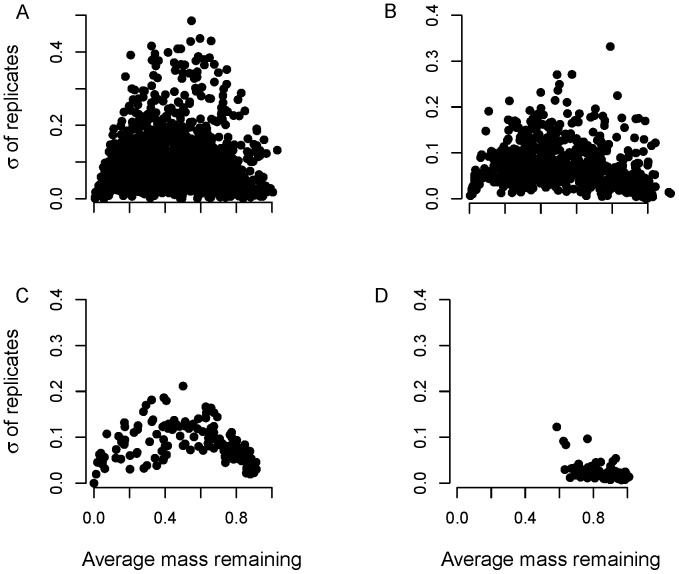
Figure of mean mass remaining versus standard deviation of replicates at each time point for real data.Mean mass remaining versus standard deviation of replicates at each time point for (A) Long-term Intersite Decomposition Experiment Team (LIDET) data, (B) Hobbie data; (C) EL data; and (D) HG data.